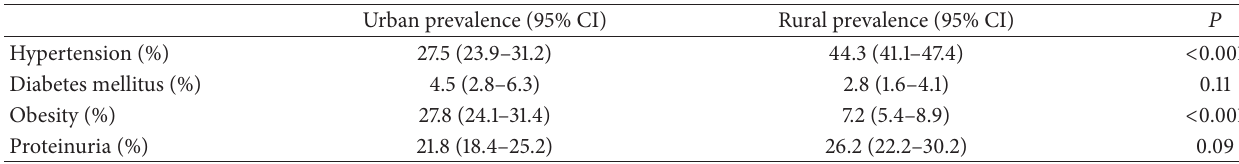
Table 2: Comparison of cardiovascular disease risk factors.